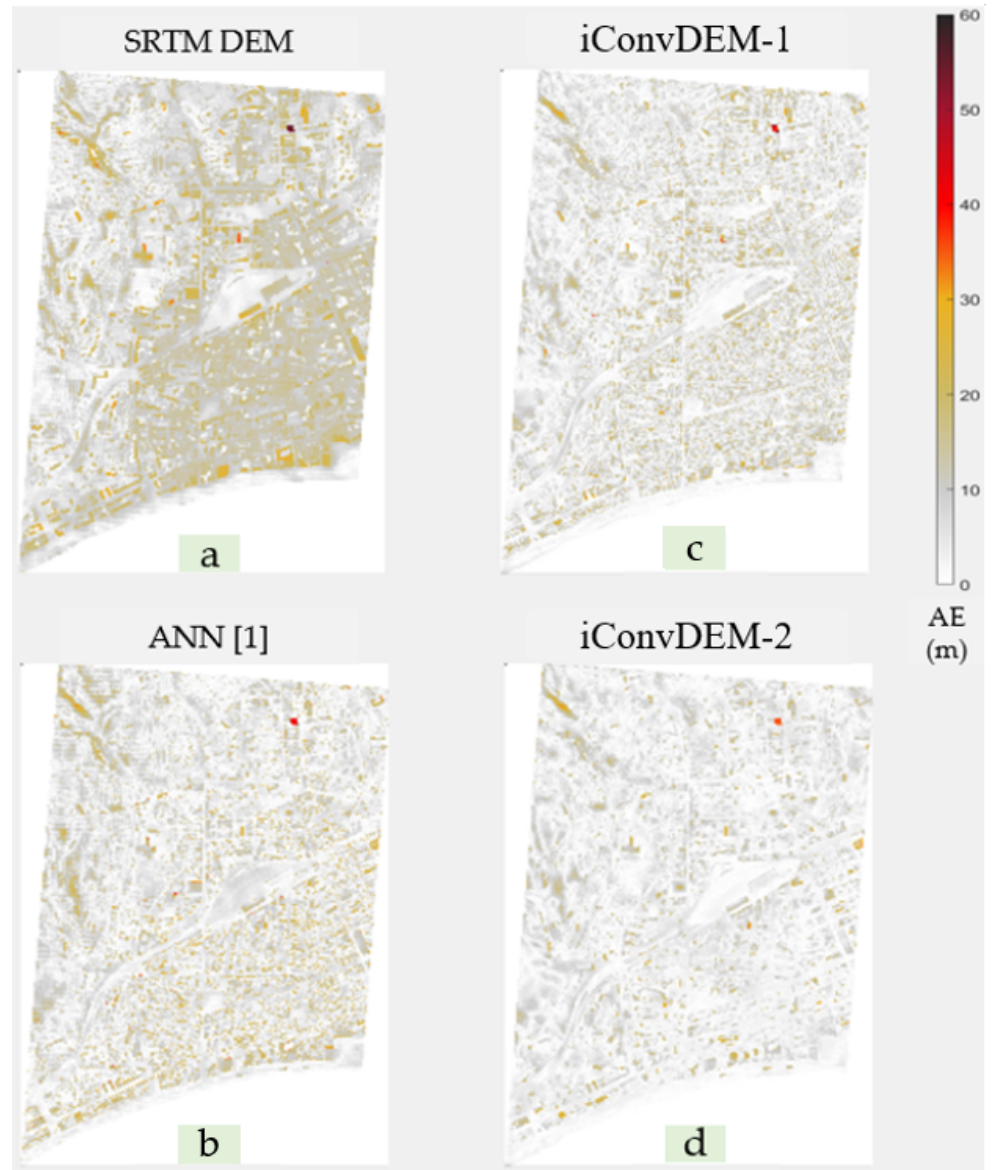
Figure 7. Absolute error, versus reference DEM, of: ( a ) SRTM DEM, ( b ) ANN [1] , ( c ) iConvDEM-1 and ( d ) iConvDEM-2.